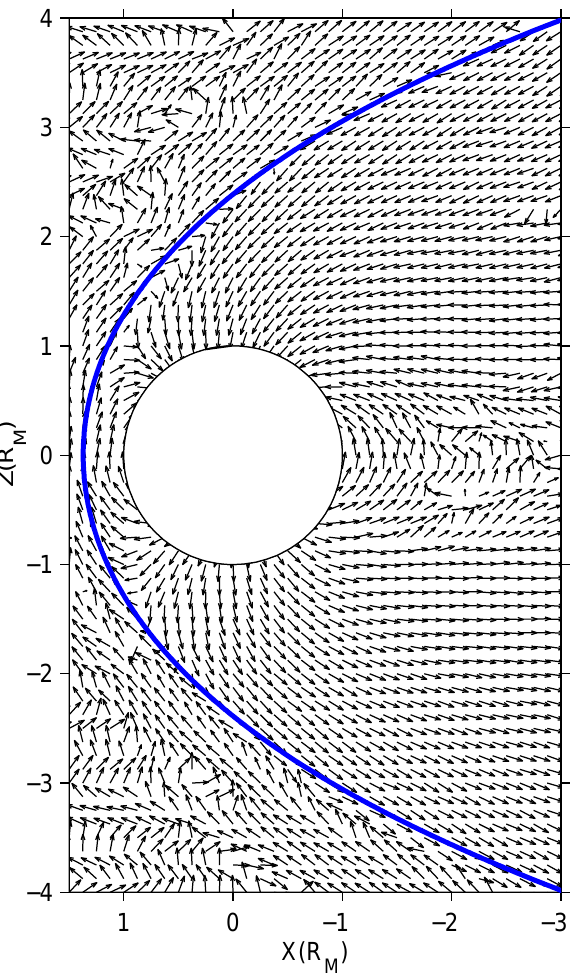
Fig. 2. Normalised magnetic field B x and B z components on the q XY -plane: [ B x ,B z ] / B 2 x + B 2 y + B 2 z . The blue solid line shows the boundary where the direction of the magnetic field changes sud- denly. The run is the same as shown in Fig.